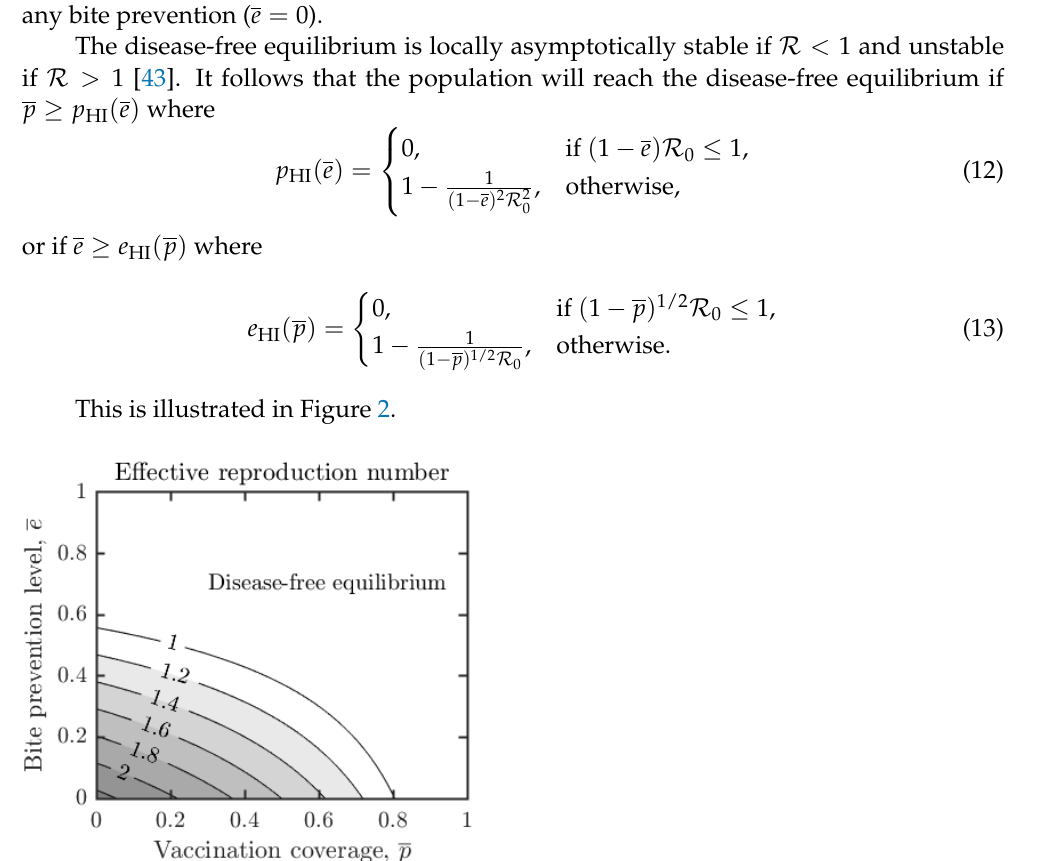
Figure 2. Dependence of the effective reproduction number, R , on vaccination coverage p and bite protection levels e in the population. Other parameter values as in Table 1. The number of secondary infections can be estimated by R 2 . Note that R < 1, i.e., one can contain outbreaks whenever p > 0.8, regardless of the value of e . If the bite prevention is higher, the vaccination coverage needed for R < 1 decreases. If e > 0.6, the outbreaks can be contained even without the